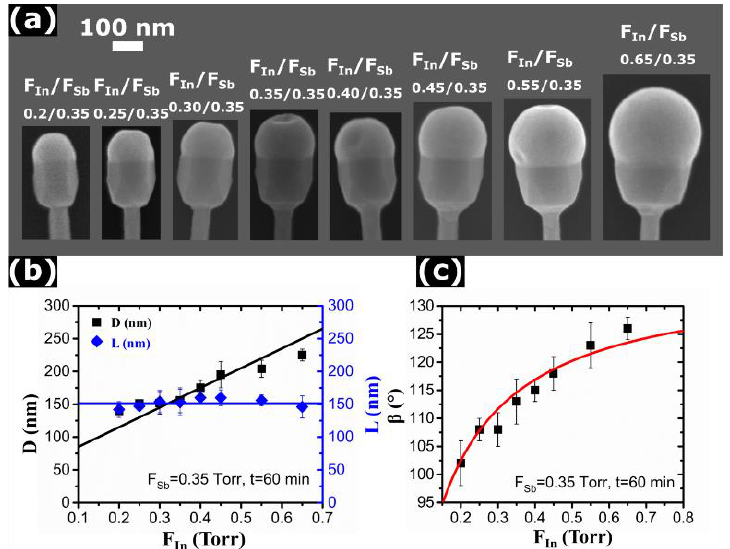
Figure 3. ( a ) Series of SEM images of InAs/InSb axial heterostructured NWs with In droplets on top, obtained after 60 min of InSb growth at a fixed F Sb of 0.35 Torr and different F In , yielding different Sb/In line pressure ratios indicated in each panel. Under these highly In-rich conditions, the In droplets always cover the whole NW facet. ( b ) Diameter and length of InSb segments versus the F In (symbols). ( c ) Contact angle of In droplets on top of InSb segments versus F In (symbols). The lines in ( b , c ) are theoretical fits discussed in the modeling section.